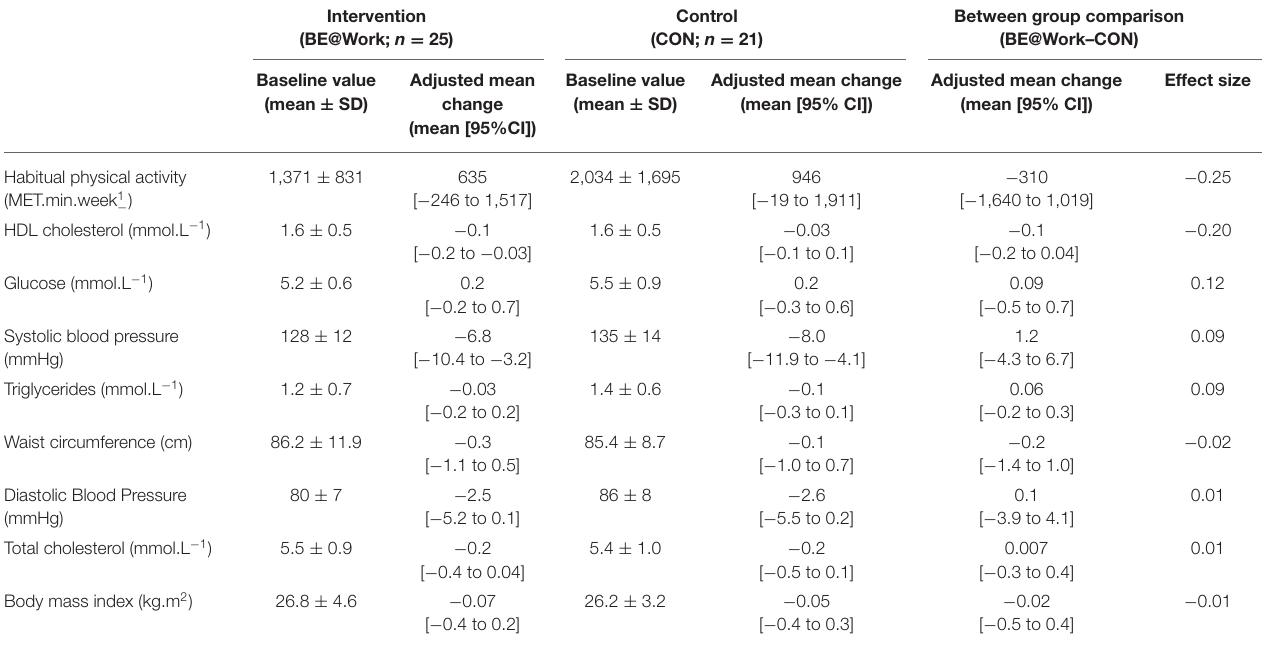
TABLE 5 | Intervention effect on cardiometabolic health variables.